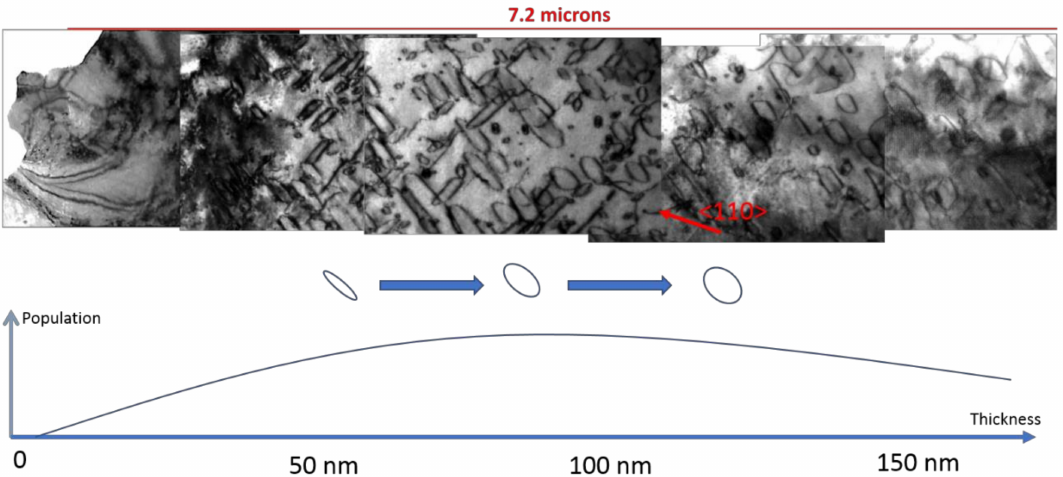
Figure 26. TEM micrograph of irradiated thin film showing the thickness dependence of loops in terms of population and visibility.